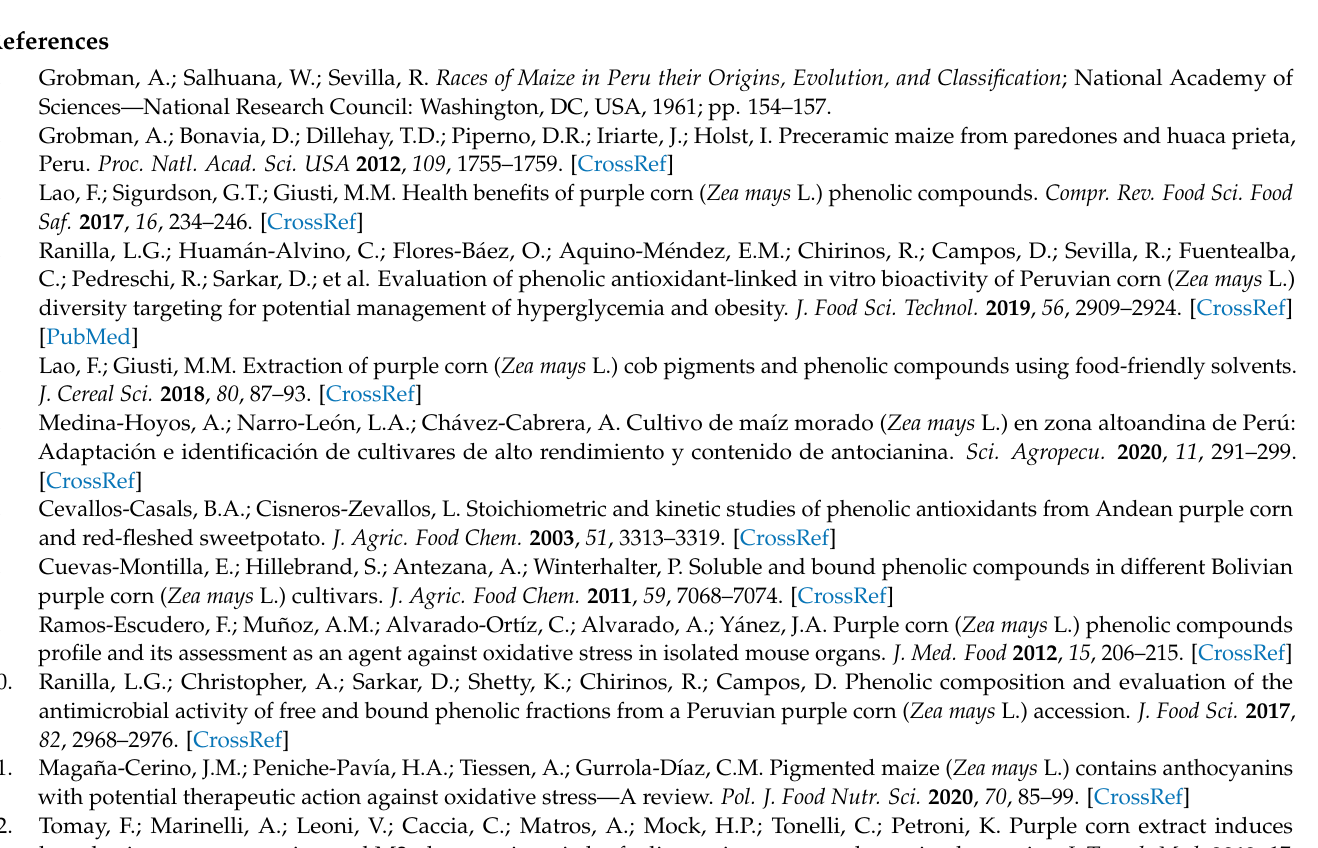
geographical location, (A): anthocyanin free fraction at 525 nm, (B): bound phenolic fraction at 320 nm, Figure S3: UHPLC chromatograms of purple corn cob sample from the lowland geographical location, (A): anthocyanin free fraction at 525 nm, (B): bound phenolic fraction at 320 nm, Figure S4: UHPLC chromatograms of purple corn cob sample from the highland geographical location. (A): anthocyanin free fraction at 525 nm, (B): bound phenolic fraction at 320 nm, Figure S5: Mass spectra of significant polar primary metabolites detected in purple corn kernels by CG-MS, Figure S6: Mass spectra of significant polar primary metabolites detected in purple corn cobs by CG-MS, Figure S7: heat map considering the top 25 t -test variables in case of purple corn cob samples grown at two different geographical locations (highland, HIGH and lowland,